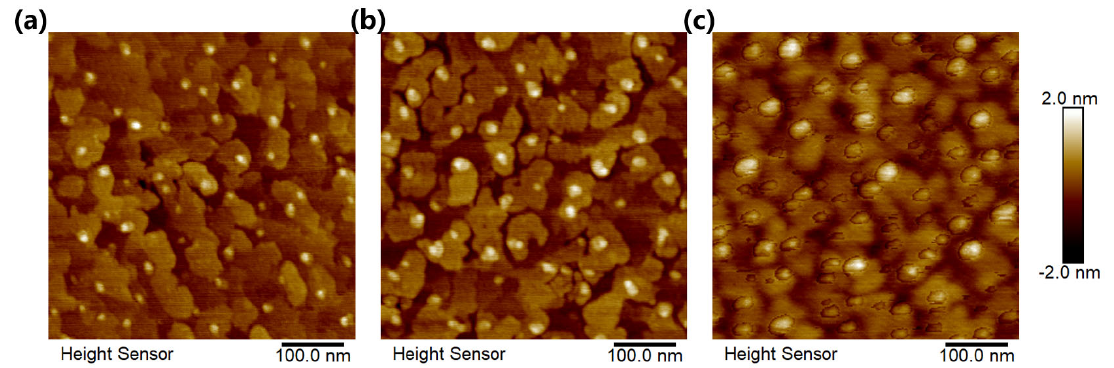
Figure 5. AFM images for samples S1 ( a ), S2 ( b ), and S3 ( c ), where white spots are assigned as QD − like centers.